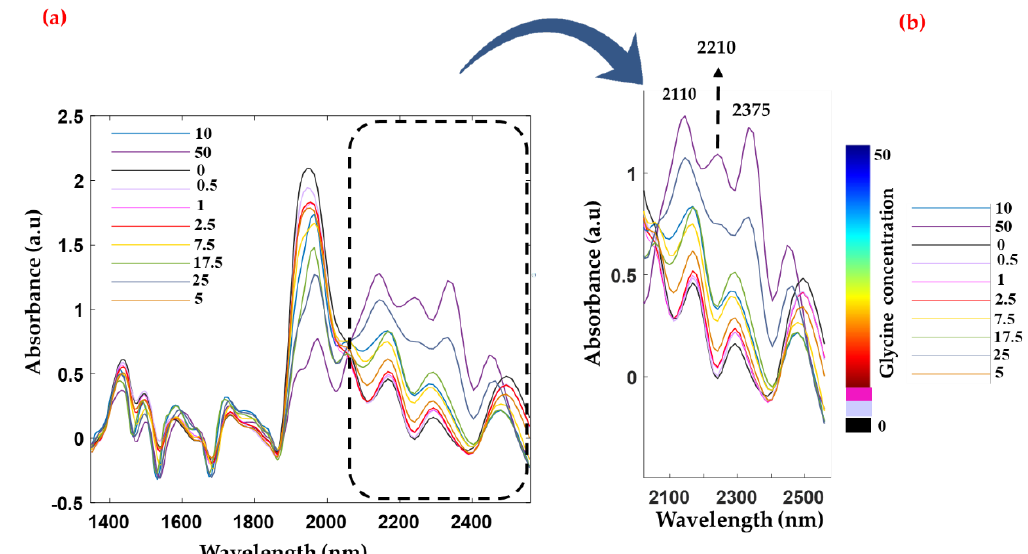
Figure 3. ( a ) Baseline corrected raw spectra of glycine-spiked human serum samples. The concentration of glycine ranges from 0–50 mg/mL. ( b ) Magnified view of 2500–2000 nm region where major contribution from glycine is observed.